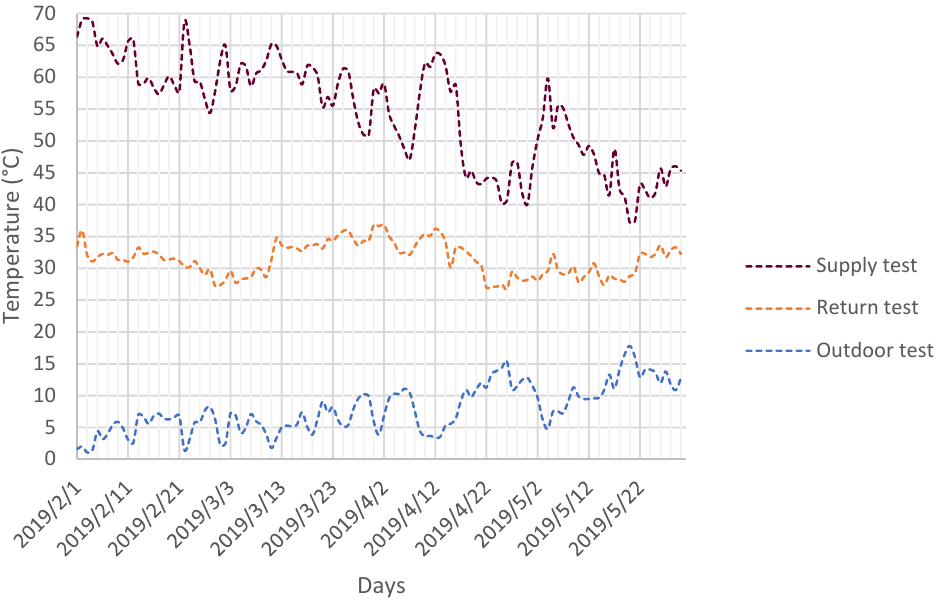
Figure 9. Supply and return temperatures in the space heating system during the test of prototype version 1.